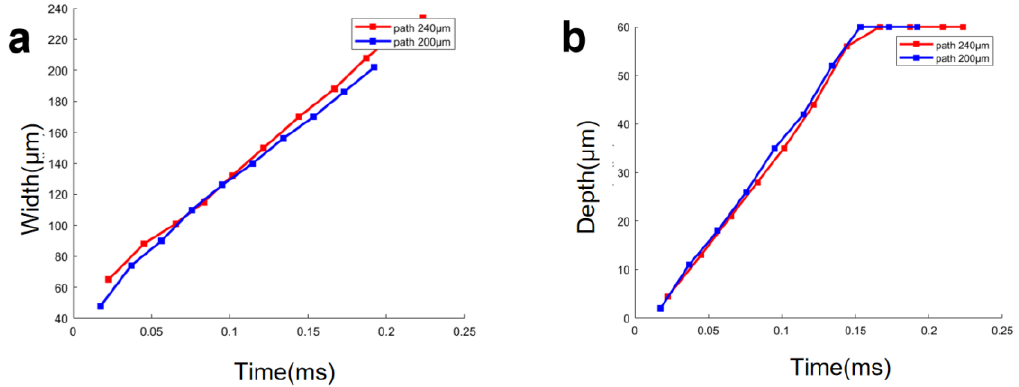
Figure 8. Effect of scanning path on micro hole shape: ( a ) depth; ( b ) width.